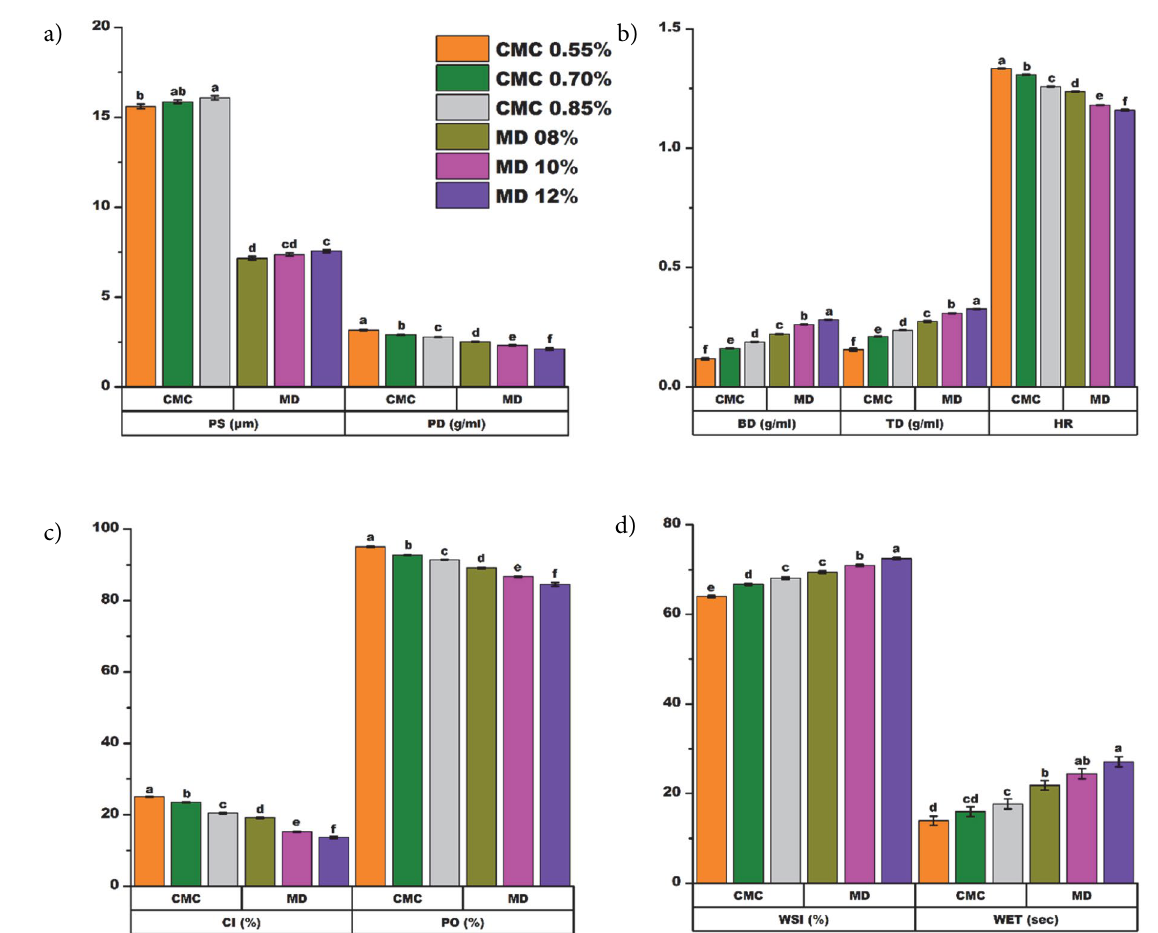
Figure 3. Effect of carriers on particle, packing and reconstitution properties of encapsulated freeze-dried mulberry leaf extract powders PS-particle size, PD-particle density, BD-bulk density, TD-tapped density, HR-Hausner ratio, CI-Carr index, PO-porosity, WSI-water solubility in- dex, WET-wettability time, CMC-sodium carboxymethyl cellulose, and